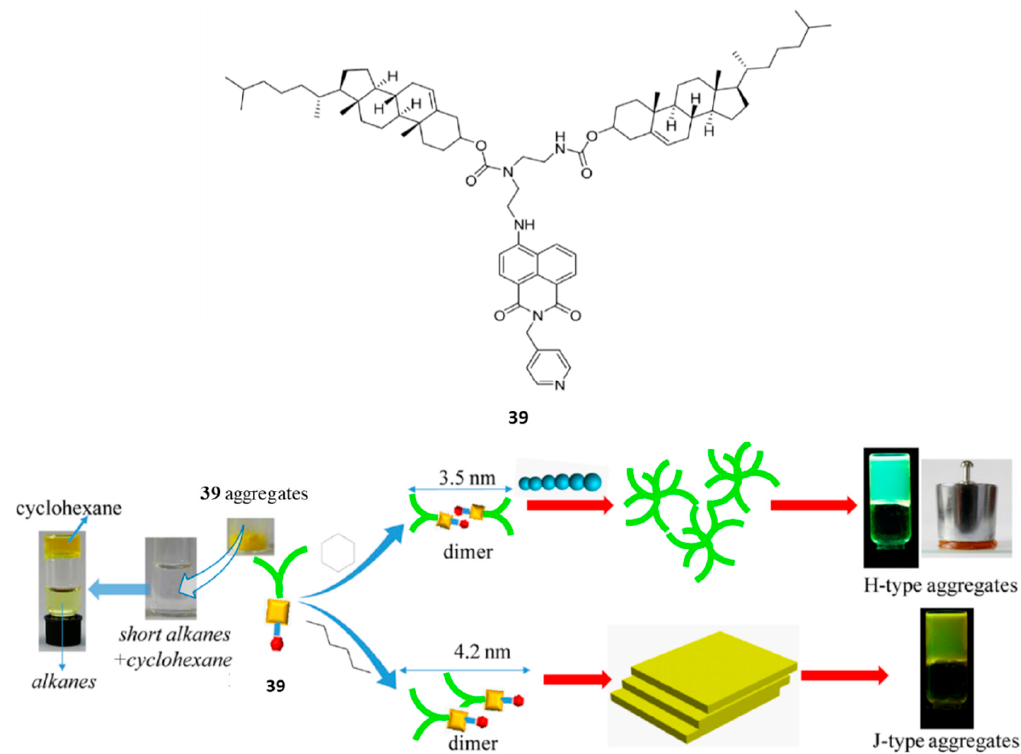
Figure 31. Top: chemical structure of gelator 39 . Bottom: proposed gelation processes and aggregation difference of 39 in cyclohexane and hexane and illustration of 39 xerogel for cyclohexane uptake from solvent mixtures. Adapted with permission from ACS [66].